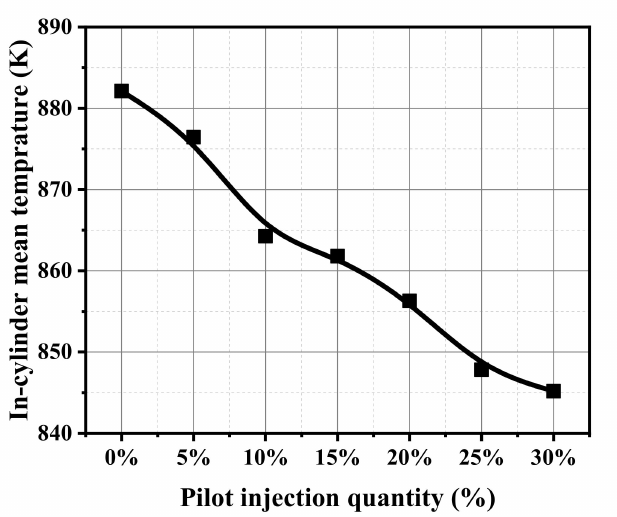
Figure 17. In-cylinder mean temperature of different pilot injection mass ratios at the beginning of